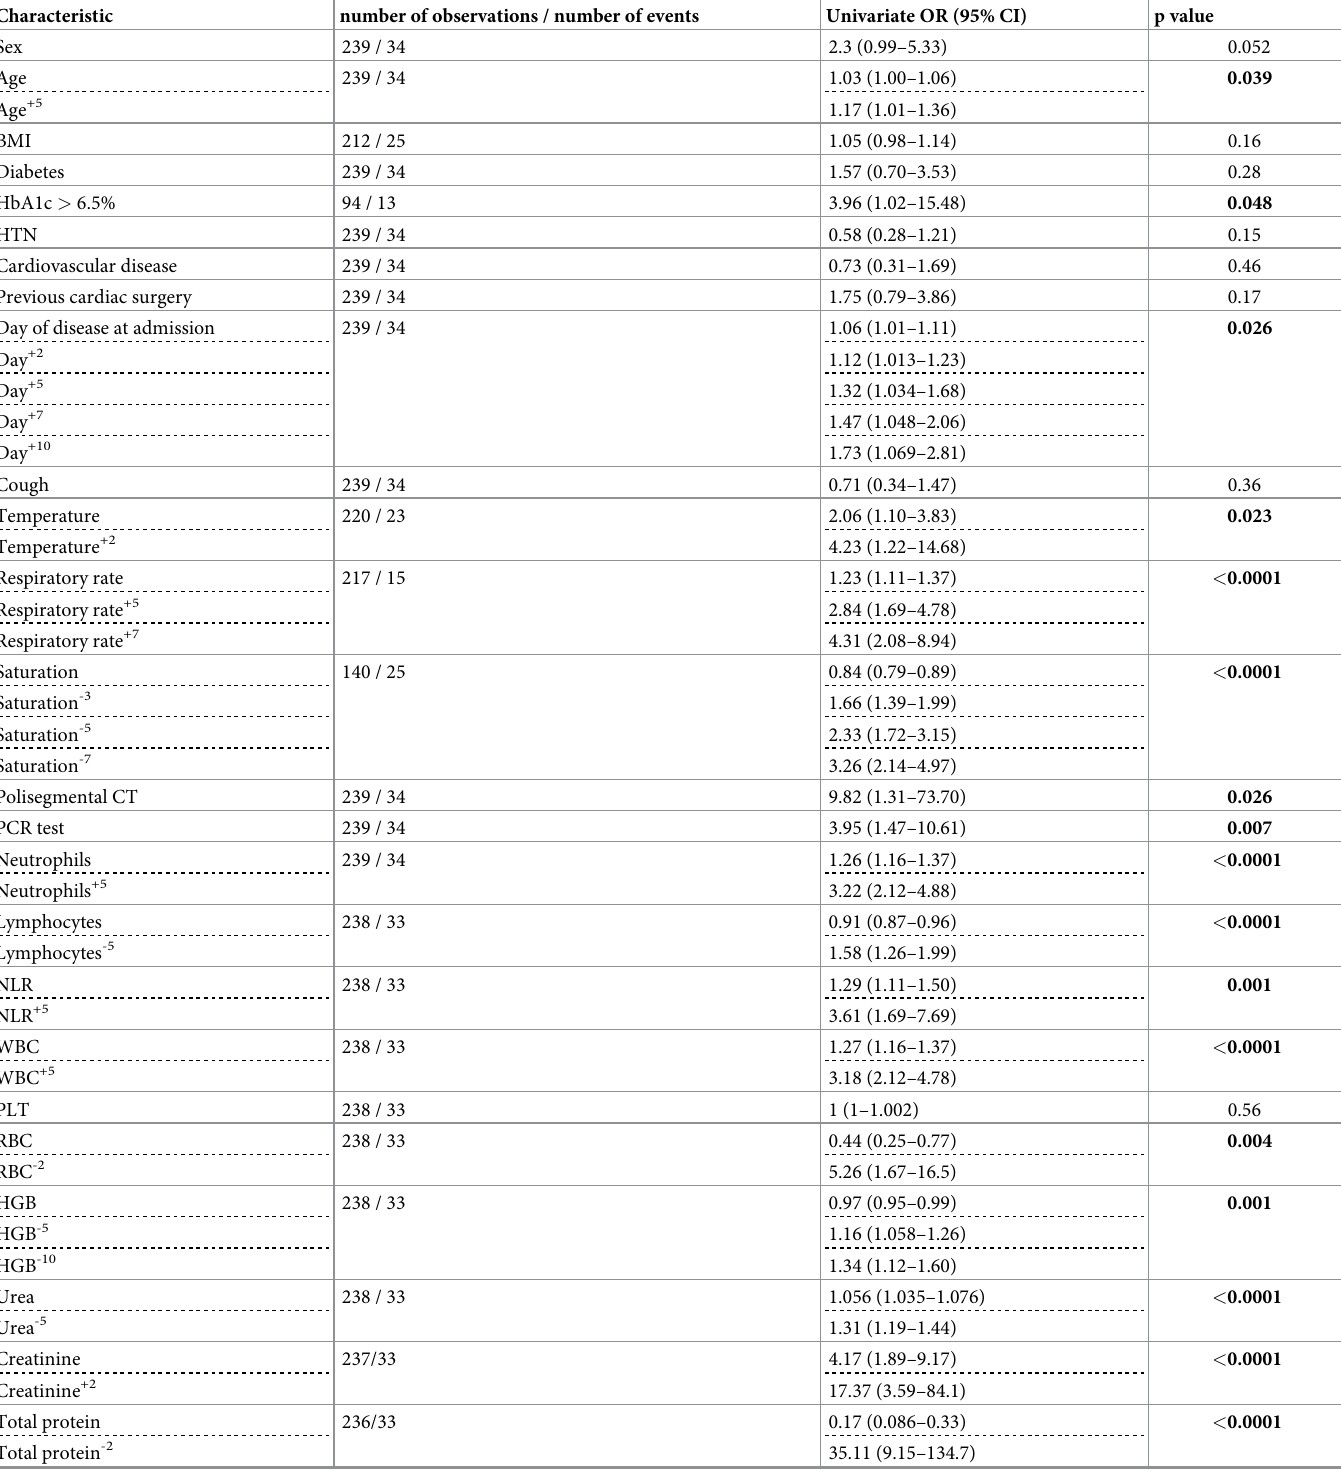
Table 2. The association between demographics, clinical, laboratory, treatment related variable and risk of in-hospital death using unadjusted logistic regression.